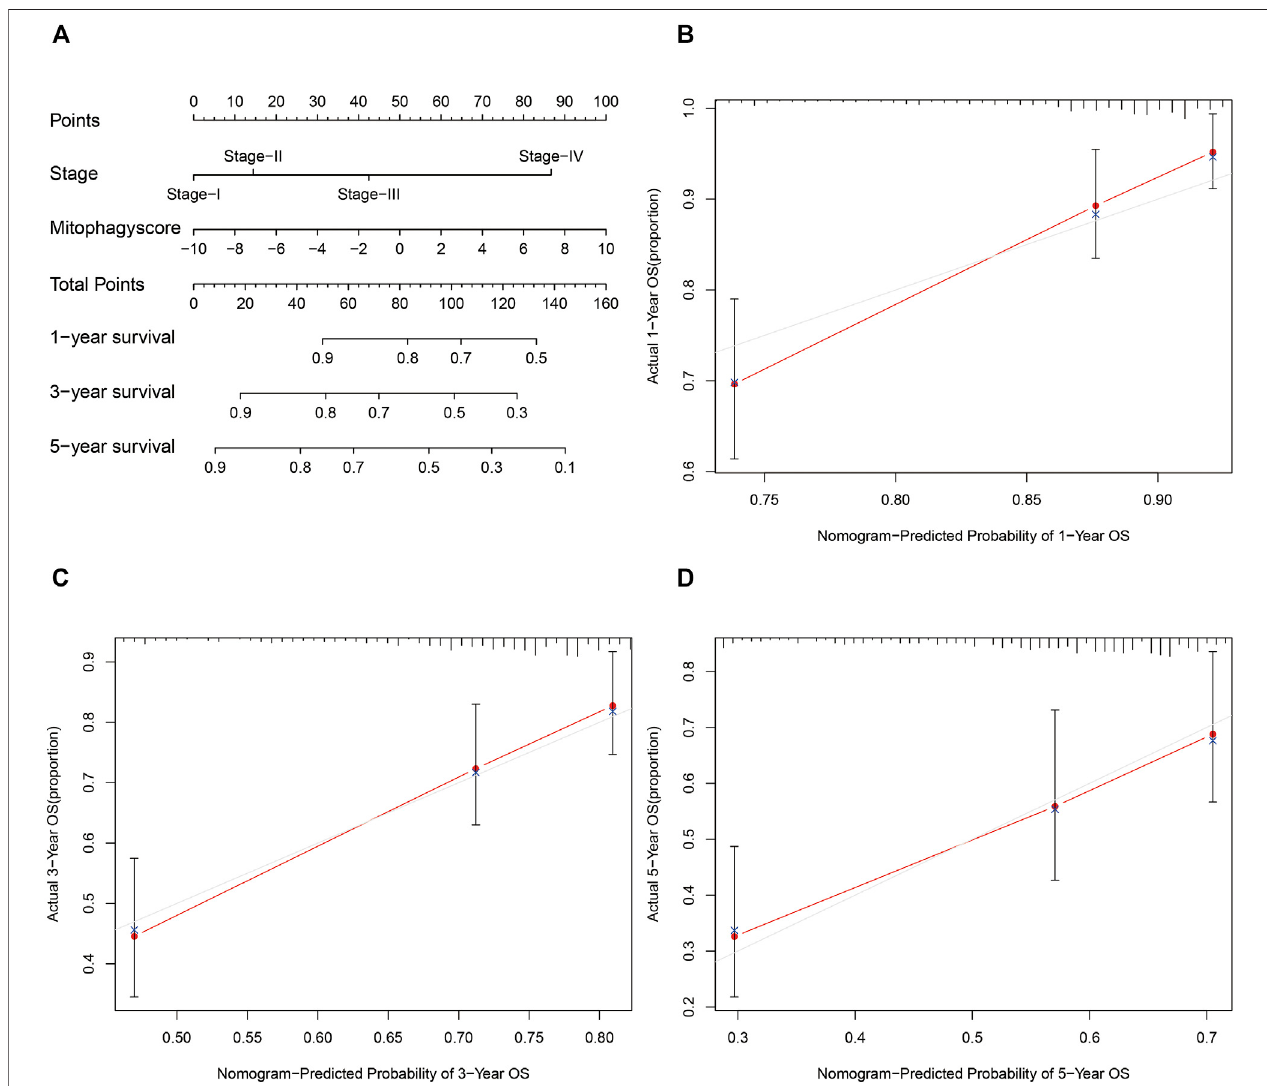
FIGURE 7 | Developed nomogram to predict the probability of survival in HCC patients (A) Nomogram built with tumor stage and mitophagyscore incorporated estimating 1-, 3-,5-years OS for HCC patients in the TCGA LIHC cohort. The calibration curves describing the consistency between predicted and observed 1- (B) , 3- (C) ,5- (D) year OS at different time points in the TCGA LIHC cohort. The estimated survival was plotted on the x -axes, and the actual outcomes were plotted on the y -axes. The gray 45-degree dotted line represents an ideal calibration mode.